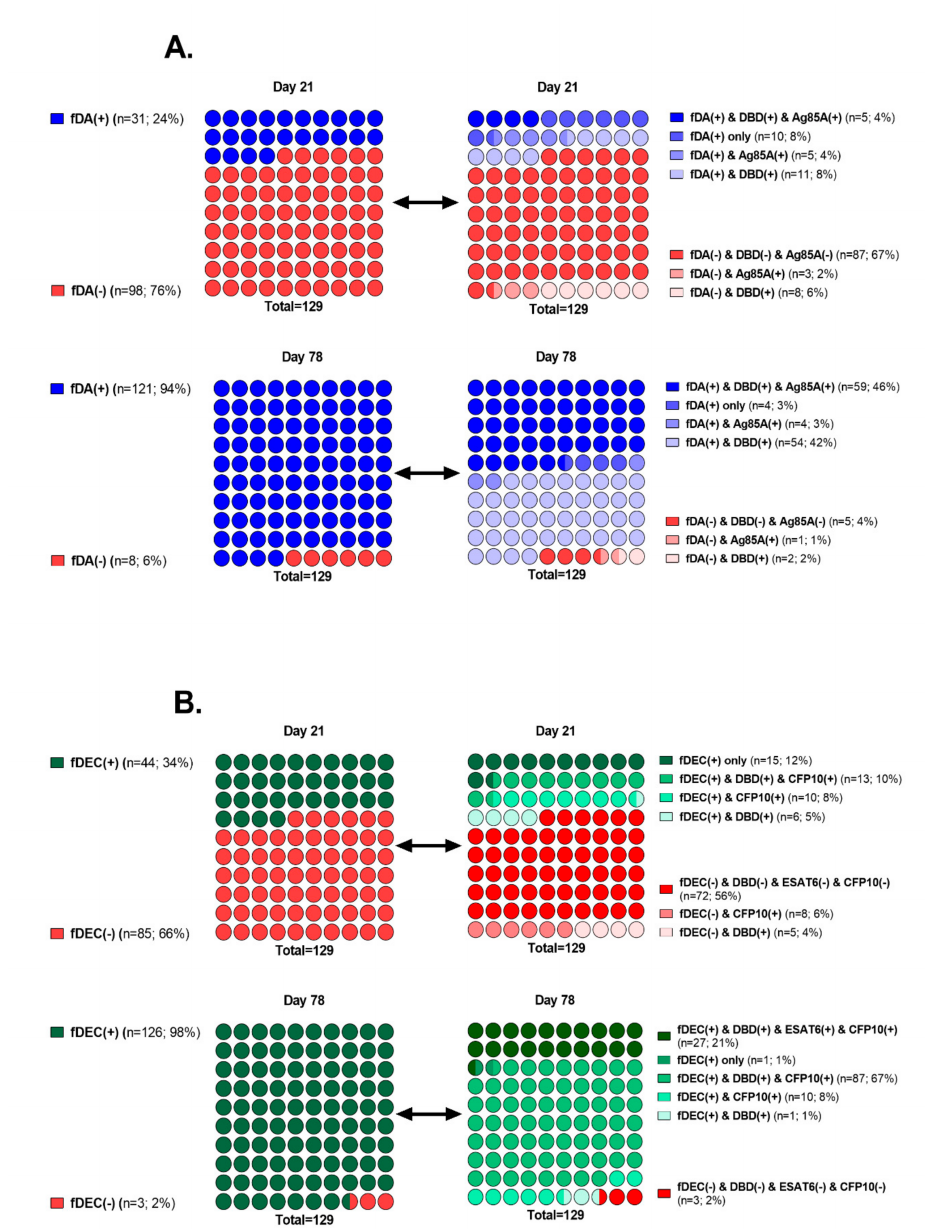
Figure 4. Humoral responses to vaccine fusions and their components in the immunized volunteers’ group on days 21 and 78. ( A ). Percentage ratio of positive / negative IgG responses to fusion DBD-Ag85a (fDA) is represented in the left dot plots. Percentage ratio of positive / negative IgG responses to fDA and its components is illustrated in the right dot plots. ( B ). Similar plots for fusion DBD-ESAT6-CFP10